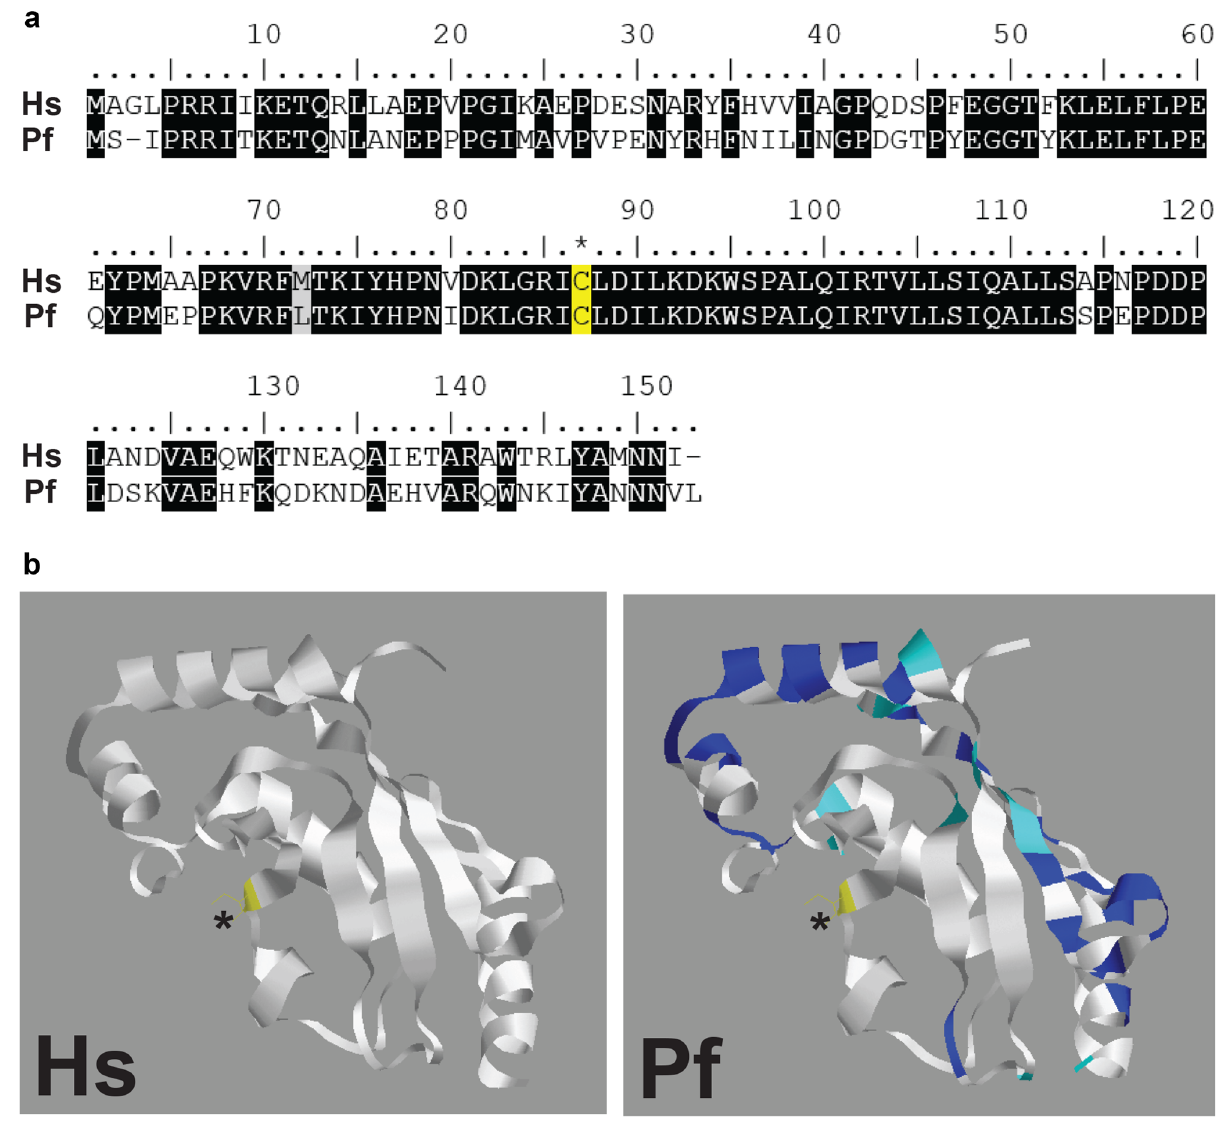
Figure 1. Structural comparison of HsUBC13 and the putative PfUBC13. ( a ) Homo sapiens (Hs)UBC13 and Plasmodium falciparum (Pf)UBC13 amino acid sequences are aligned, with identical residues in the two sequences highlighted in black. The active site cysteine residue that binds activated ubiquitin covalently and reacts with NSC697923 in human UBC13 is highlighted in yellow and marked with an asterisk. ( b ) Three- dimensional structures with the active site cysteine highlighted in yellow and marked with an asterisk. In the PfUBC13 structure, amino acid residues where the two sequences differ are highlighted in blue, or in cyan if the substitution is